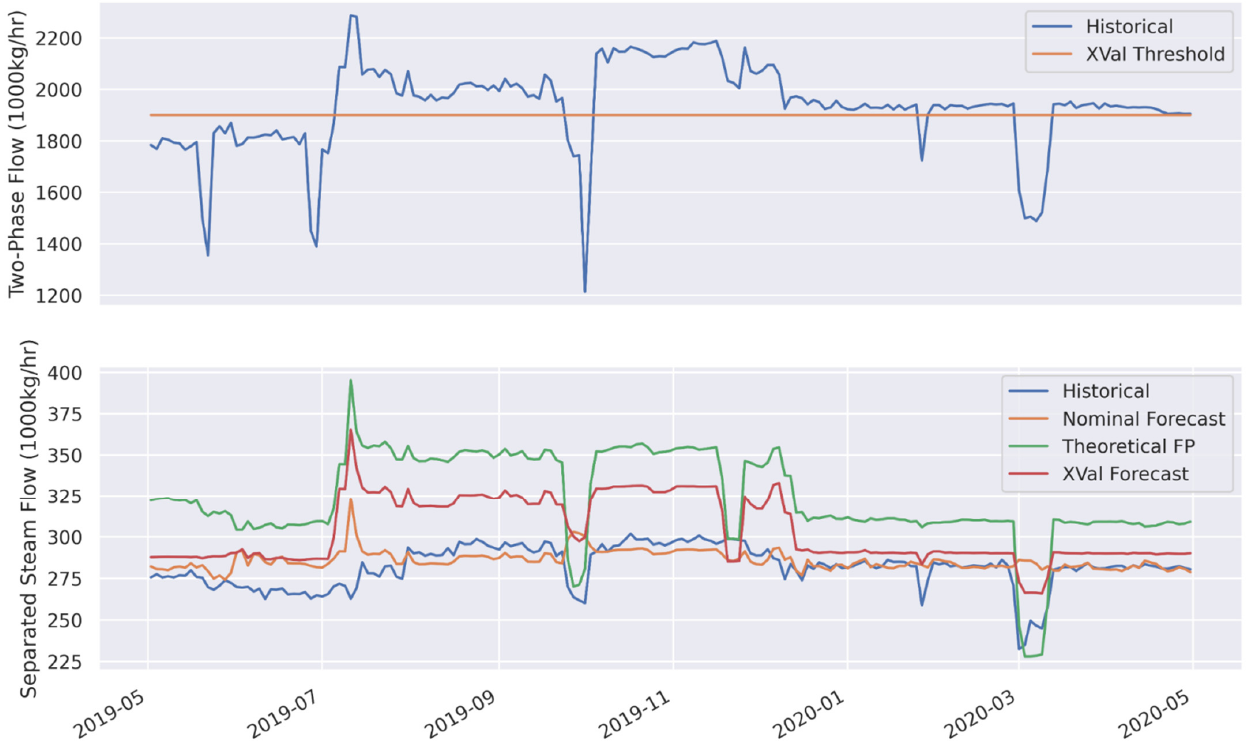
Figure 10. Results from a flash plant modeling cross-validation experiment where models were trained only with two-phase input mass flow less than 1900 tonne/h. The top plot shows the two-phase mass flow through FP16IP+ with the training data limitation. The bottom plot shows the historical separated steam flow compared to predictions by a baseline model trained on all data, the cross-validation (xval) model, and a theoretical model.